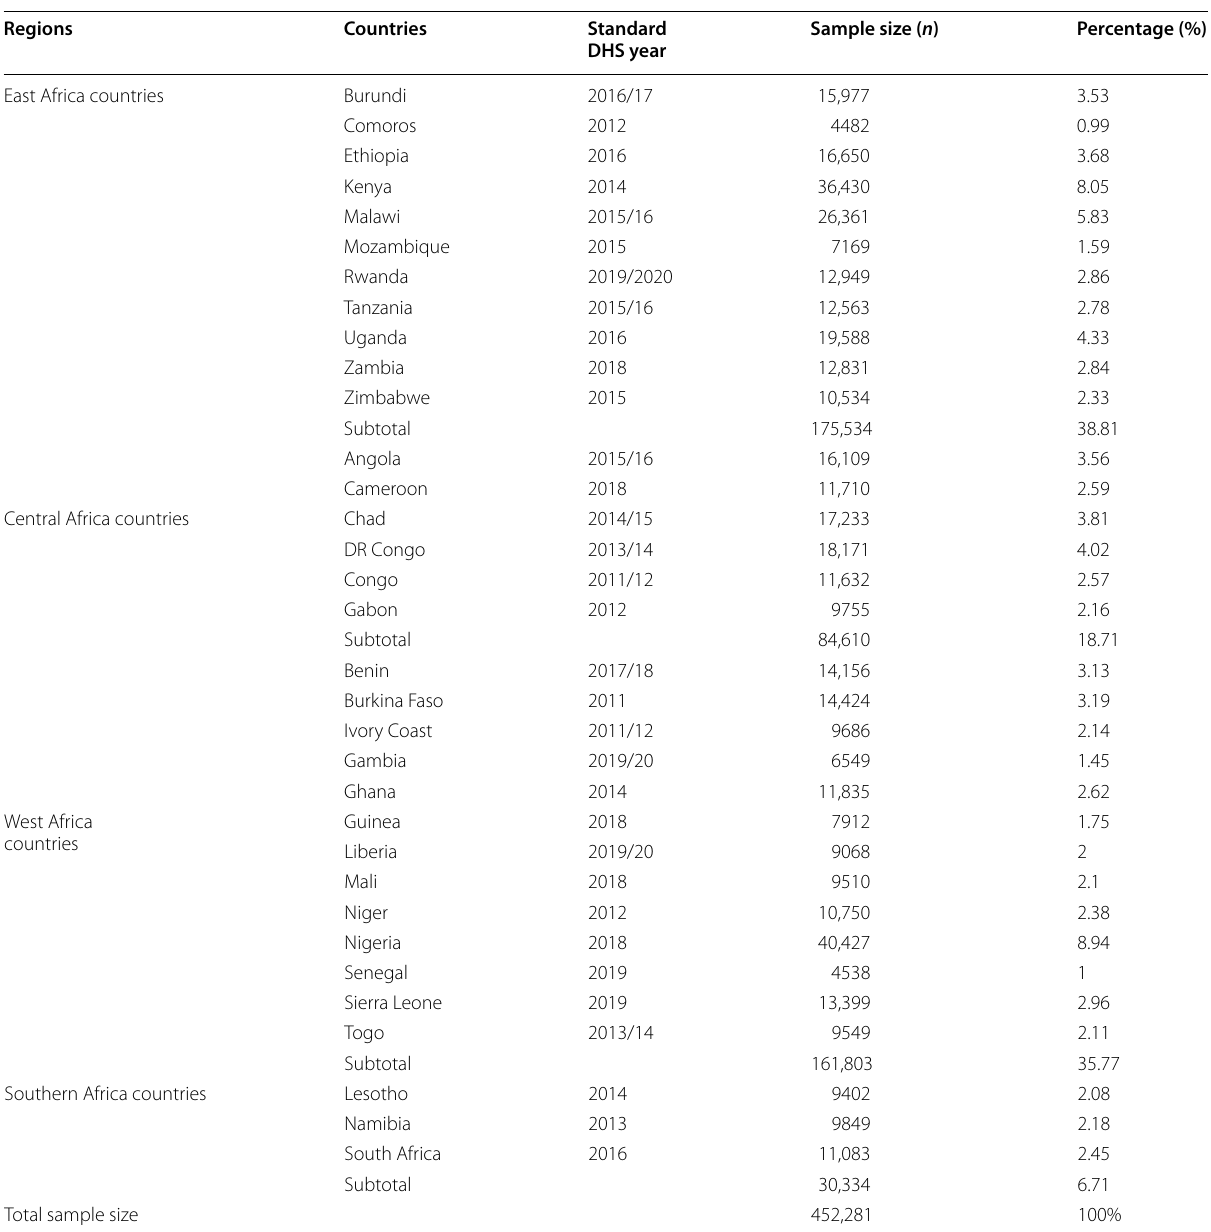
Table 1 Sample size determination in the study of pooled prevalence of open defecation and determinants among households in Sub-Saharan Africa Countries with Recent DHS report from 2010/11 to